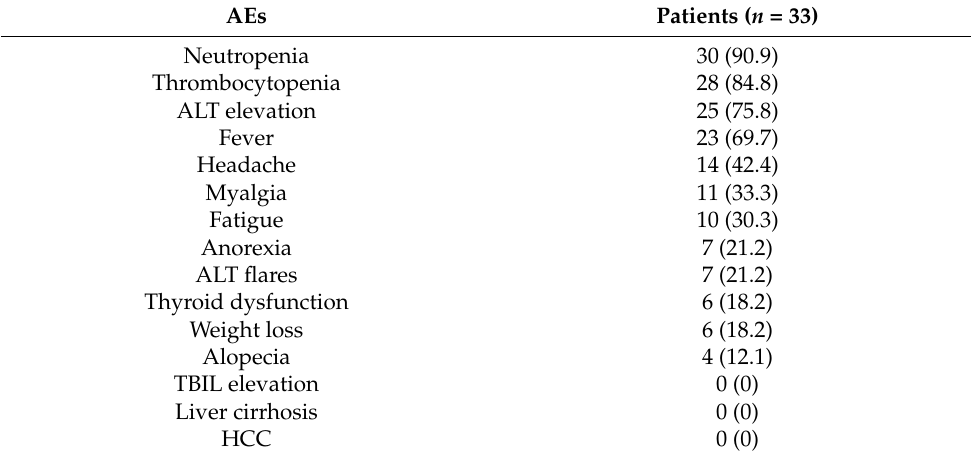
Table 3. Safety of the study population, n (%). AEs Patients ( n =